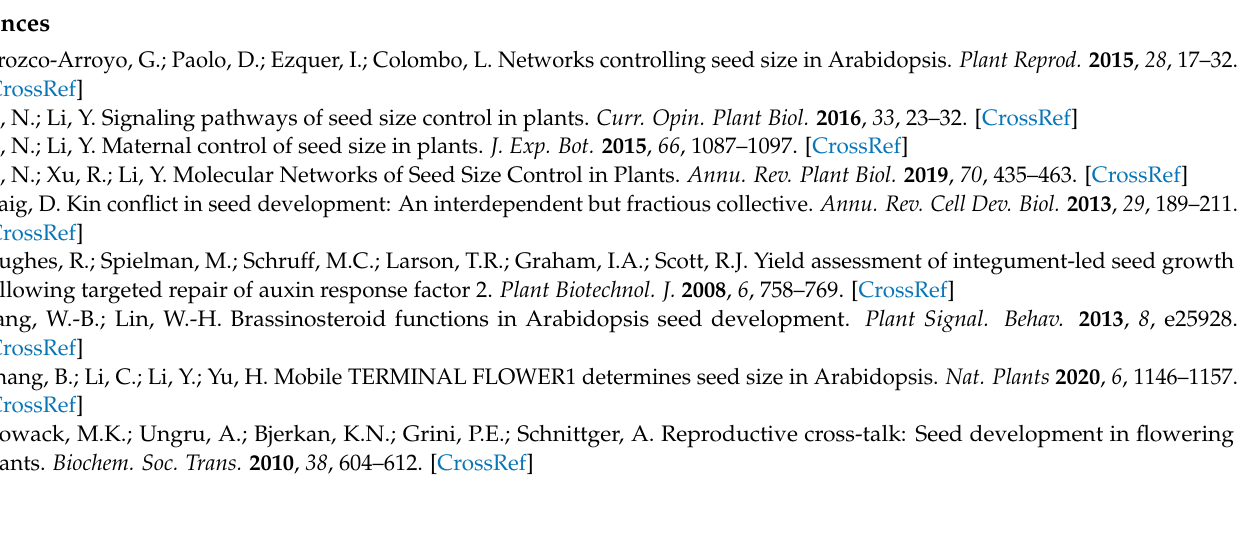
Figure S2: Schematic representation of the E2Fa gene; Table S1: List of